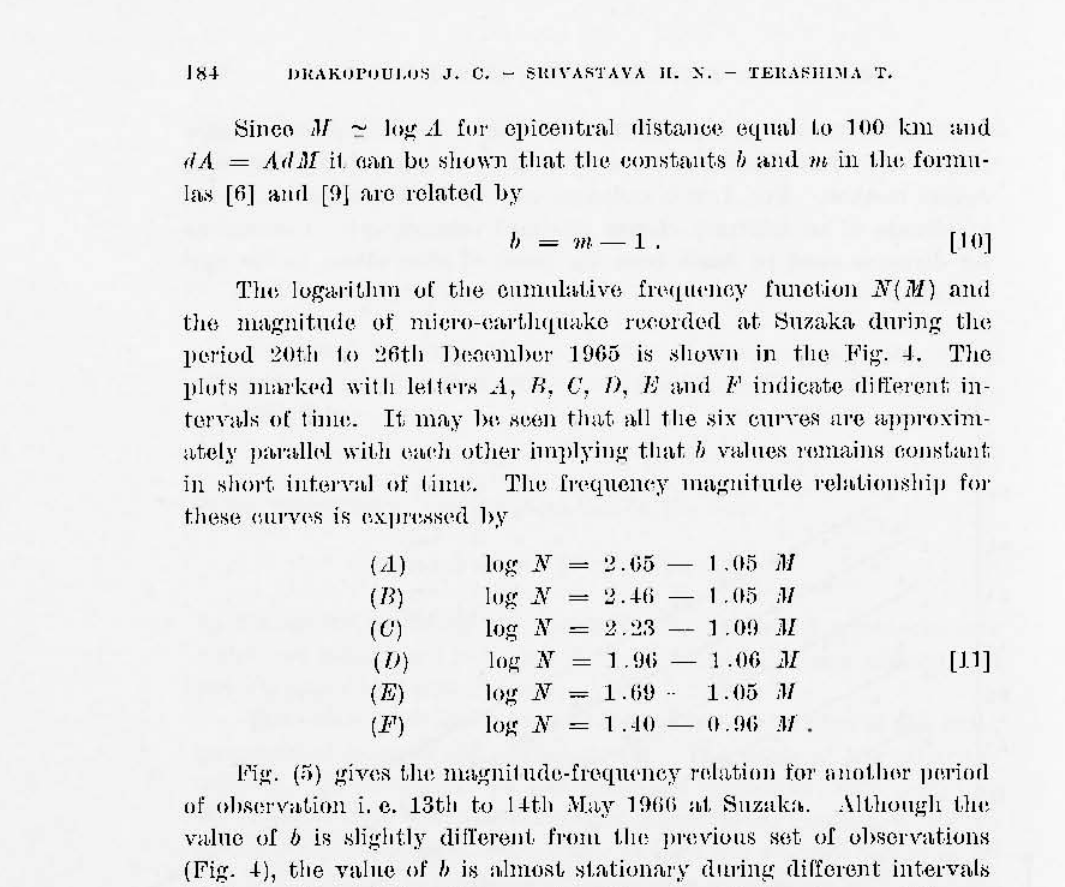
(Fig. -i), tho valne of li 18 almof\1, Htatiollal'y dlL]'ing" difIorl\nt int,crvafi; or